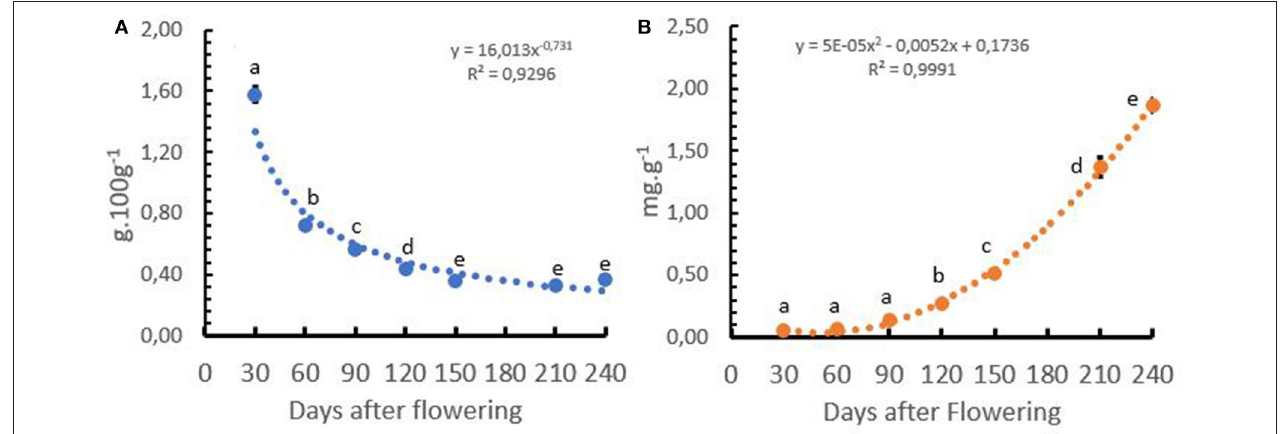
FIGURE 8 | Calcium (Ca + 2 ) concentration (A) and uptake of Ca + 2 (B) by the coffee cherries after flowering to harvest in Coffea arabica L. cv. Castillo ® . Points represent the mean values for each of the replicates ± standard error. Different letters represent statistically significant differences among the treatments ( P < 0.05, LSD